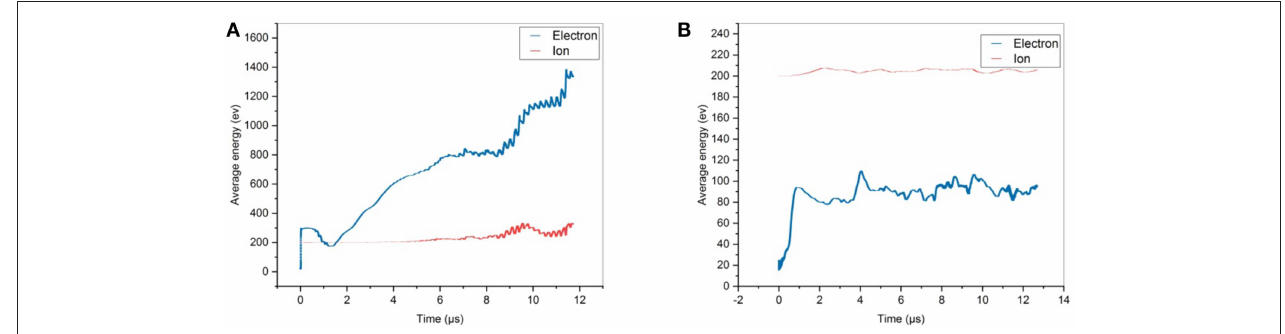
FIGURE 2 | Averaged electron and ion energy with particle re-injection method across the axial boundaries (A) with random azimuthal positions and (B) preserving azimuthal positions. Results correspond to a case using physical parameters reported in Table 1 (but using an azimuthal simulation domain length of L y with number of particles per cell N ppc 500 and mesh nodes N g 1,000 (corresponding to a cell size 1 y 0.36 λ De ). = = =